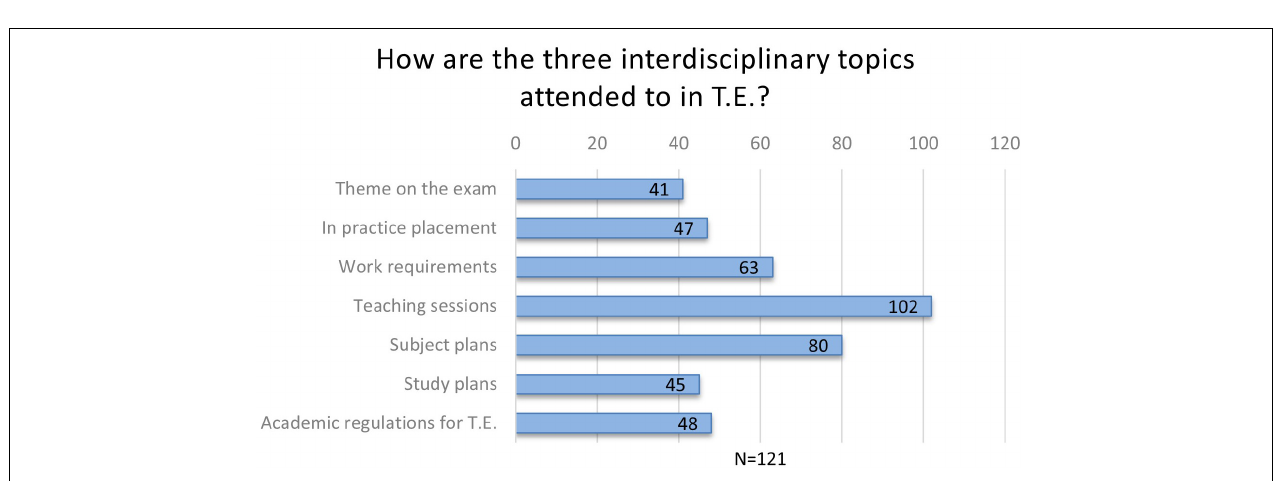
FIGURE 2 | Teacher educators’ report on their work with interdisciplinarity.